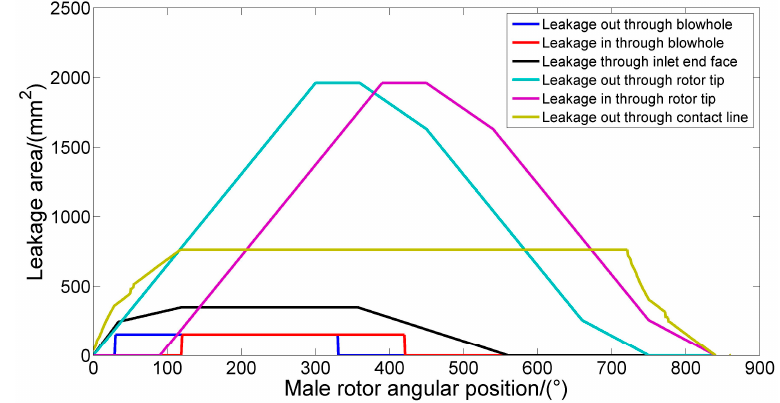
Figure 7. Leakage paths area.